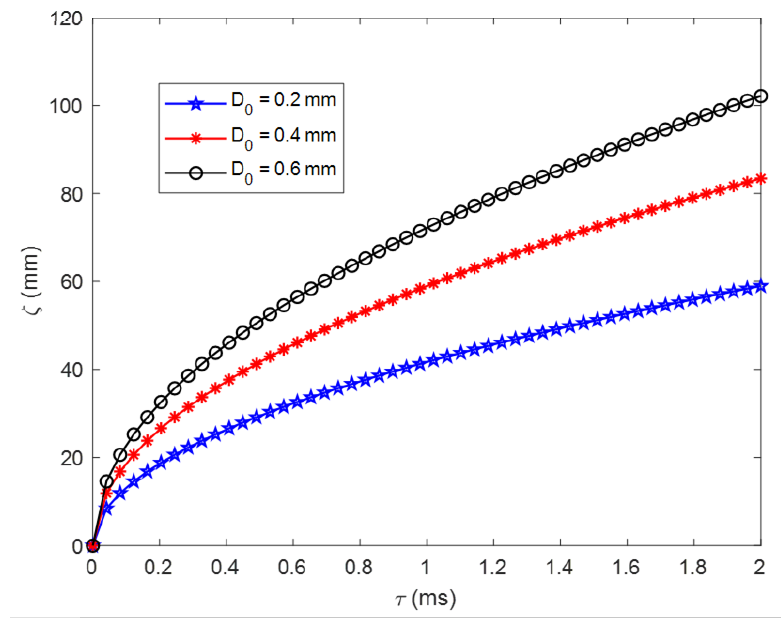
Figure 8. Effect of orifice diameter